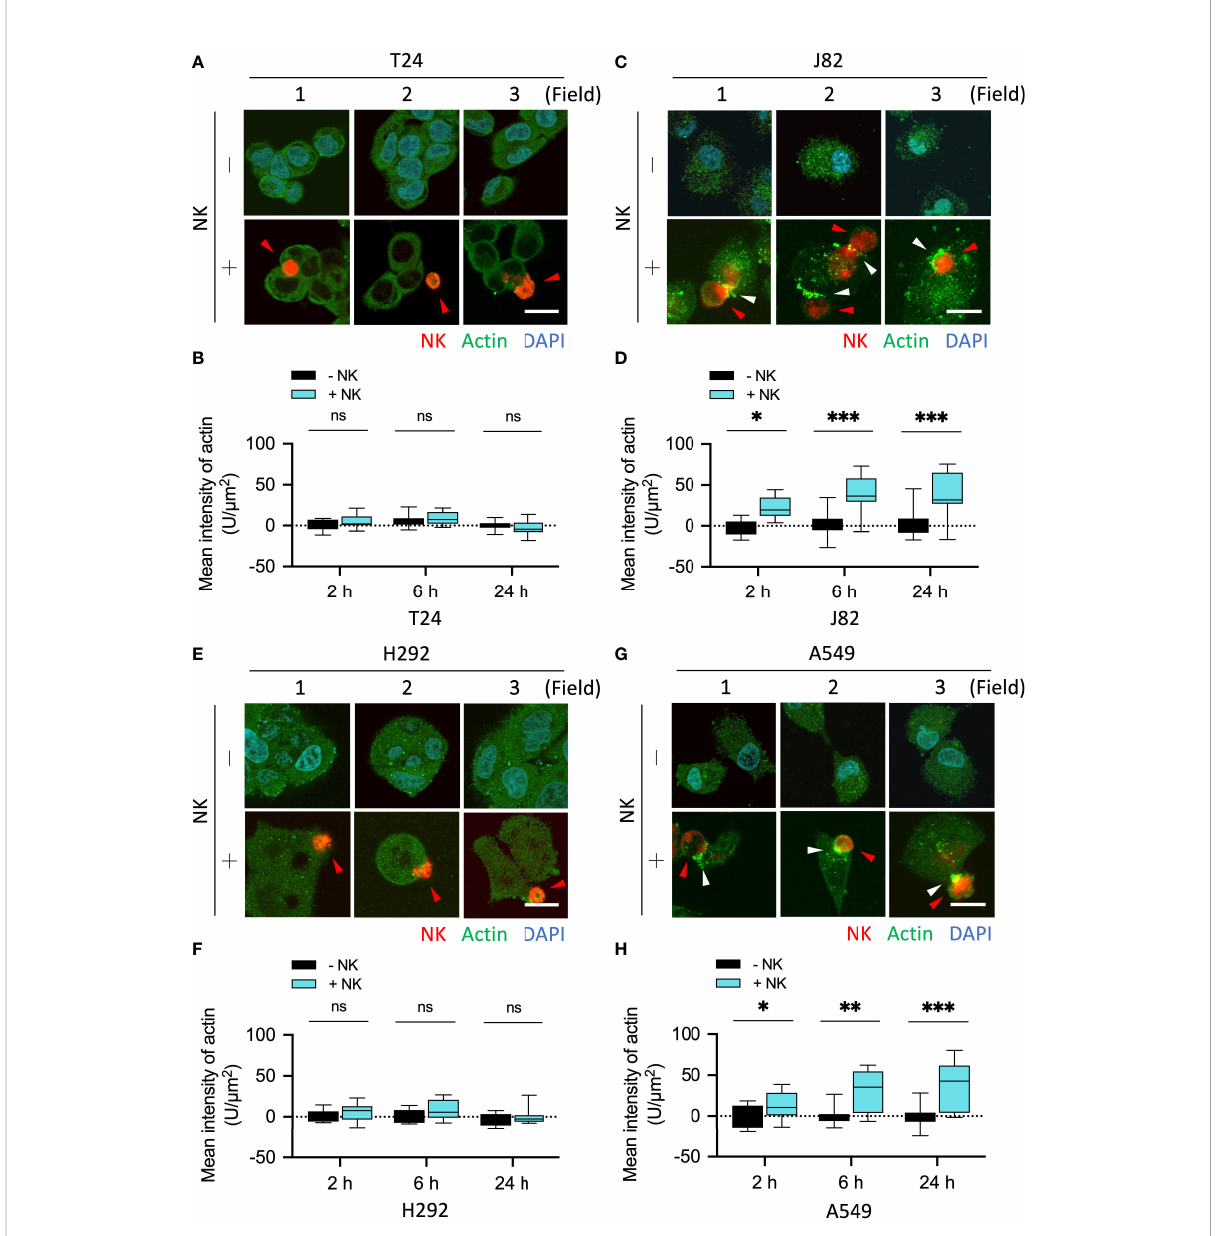
FIGURE 3 NK cells induced actin responses at the immune synapses in the immune-resistant cancer cells. (A, C) Comparison of the expression of actin fi laments in NK cell-interacted cancer cells. T24 and J82 cells were incubated with NK cells for 2, 6 and 24 h, and the expression of actin fi laments was detected using immuno fl uorescence assays. (B, D) The intensity of actin ’ s response at the immune synapses was measured and quanti fi ed by ImageJ. (E, G) H292 and A549 cells were incubated with NK cells for 2, 6 and 24 h, followed by the detection of actin fi laments expression. (F, H) Quanti fi cation of the intensity of actin response at the immune synapses using ImageJ. ns, not signi fi cant; *P < 0.05; **P < 0.01; ***P < 0.001. Data are presented as mean ± s.d. (two-way ANOVA with Sidak's multiple comparisons test). Red arrowhead, NK cell; white arrowhead, actin fi laments. Scale bars, 20 µm. Data derived from 10 fi elds, each including 2 – 3